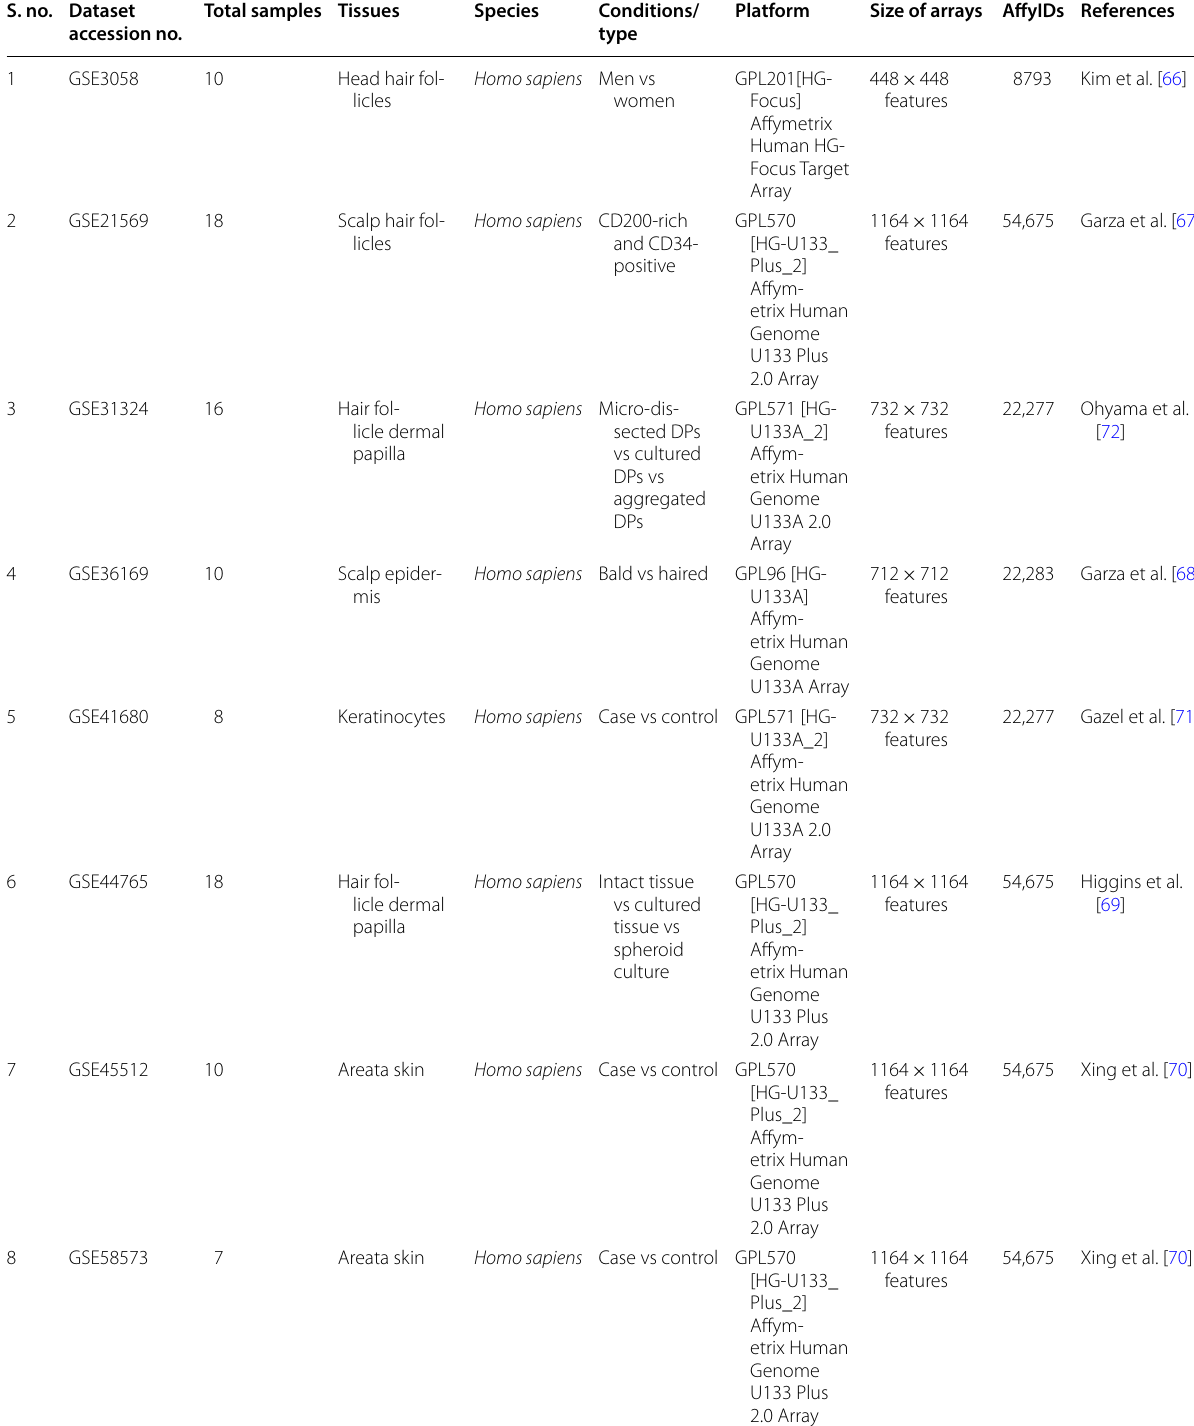
Table 1 List of cDNA datasets S. no. Dataset Total samples accession no.